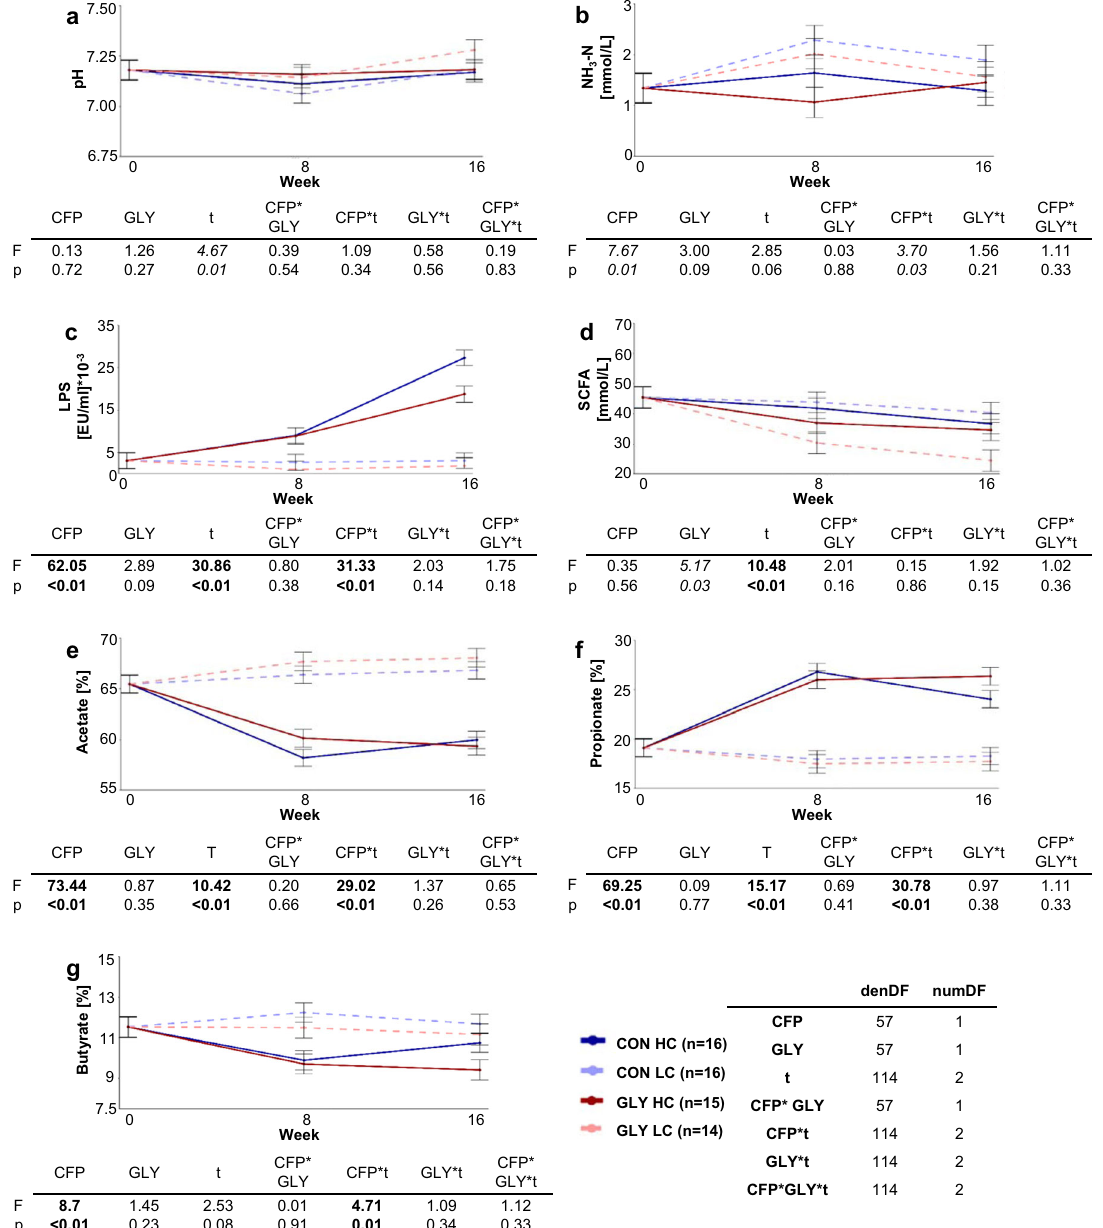
Fig. 1 In fl uences of concentrate feed proportion and glyphosate on ruminal parameters. In fl uences of concentrate feed proportion (CFP) and glyphosate on ruminal pH ( a ), ruminal ammonia (NH 3 -N) concentration ( b ), ruminal lipopolysaccharide (LPS) concentrations ( c ), and total ruminal short-chain fatty acid (SCFA) concentrations ( d ). Furthermore, proportions of the major SCFAs acetate ( e ), propionate ( f ), and butyrate ( g ) are depicted. Displayed are group lsmeans together with their respective standard error and the results of one-tailed ANOVAs of linear mixed effects models with fi xed factors CFP, glyphosate exposure (GLY), time ( t ), and the interactions for the individual parameters. Number of individuals ( n ) and degrees of freedom were identical for all parameters and are displayed in the fi gure. Blue: control diet (CON), red: glyphosate contaminated diet (GLY), dark solid lines: high CFP (HC), light dashed lines: low CFP (LC), denDF: denominator degrees of freedom, numDF: numerator degrees of freedom, values in bold: p < 0.01, values in italics: p <